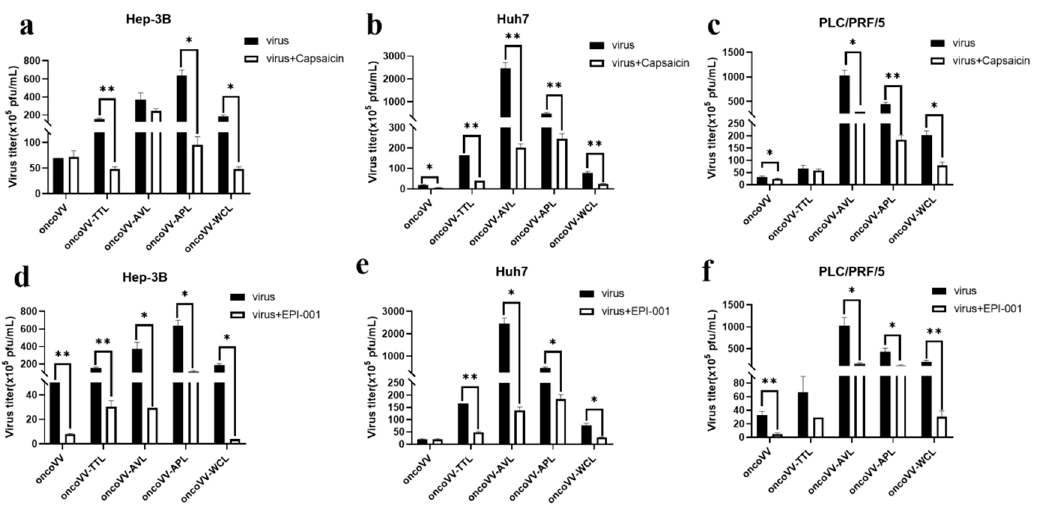
Figure 9. Virus yields in Hep-3B, Huh7, and PLC/PRF/5 cells. ( a – c ) Virus titers in HCC treated with capsaicin. ( d – f ) Virus titers in HCC treated with EPI-001. HCC were maintained for 12 h and treated with capsaicin or EPI-001, followed by 5 MOI of oncoVV or recombinant vaccinia virus. The samples were collected at 36 h postinfection (* p < 0.05, ** p < 0.01). OncoVV served as control. Either 100 μ mol/L of capsaicin or 100 μ mol/L of EPI-001 was used in Hep-3B and PLC/PRF/5 cells; 250 μ mol/L of capsaicin or 100 μ mol/L of EPI-001 was used in Huh7 cells.